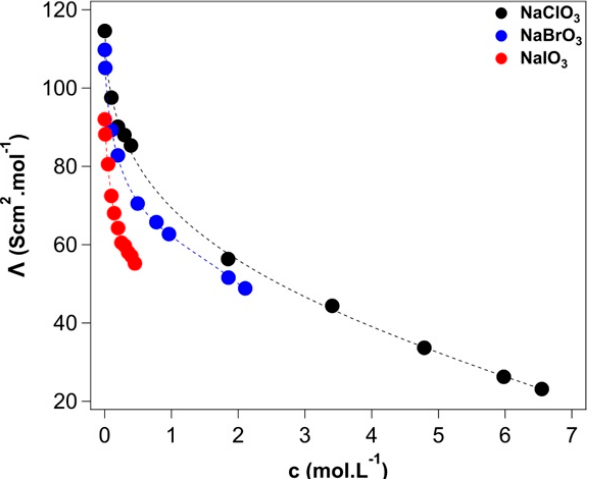
Figure 3. Molar conductivity Λ as a function of concentration (c, in molar units) of sodium chlorate (black), bromate (blue), and iodate (red) solutions. Dotted lines represent the fitting of Equation (A10). The experimental absolute error on the molar conductivity values is ± 0.1.